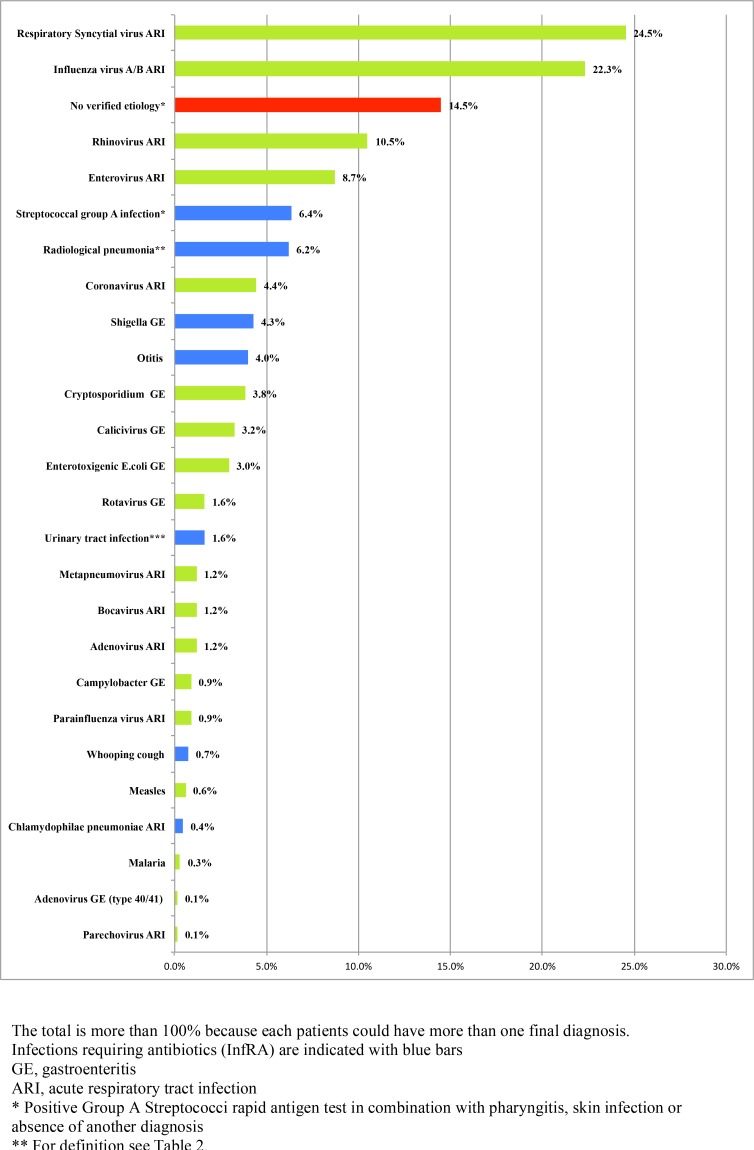
Final diagnoses in patients.